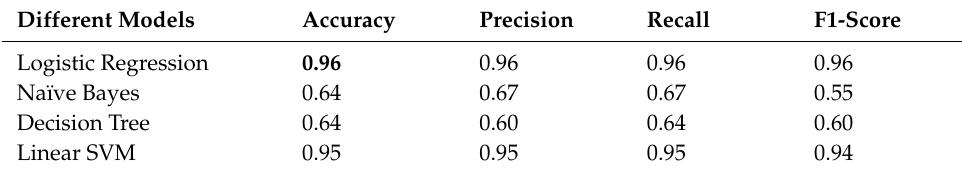
Table 8. Experimental results for recommendation